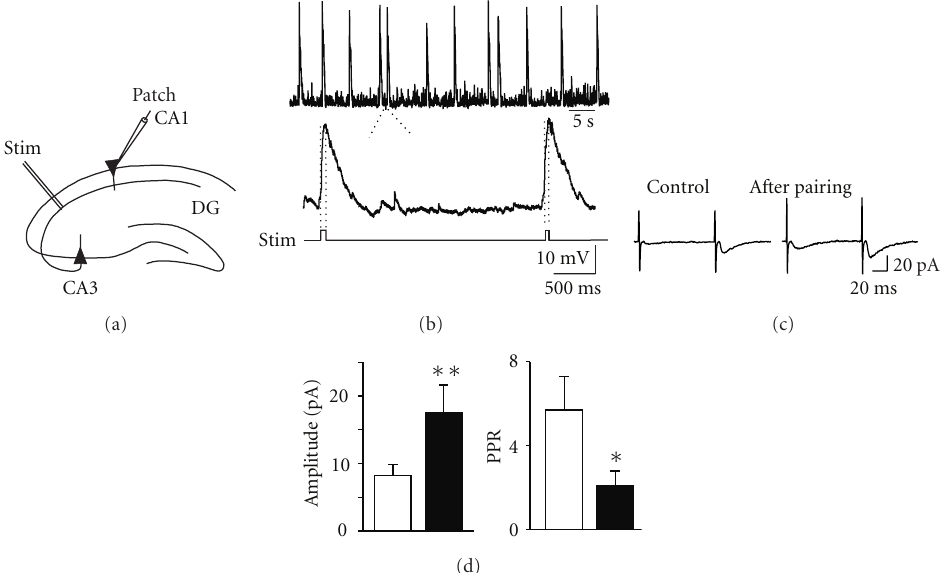
Figure 2: Pairing GABA-mediated GDPs with Scha ff er collateral stimulation persistently enhances synaptic strength at glutamatergic CA3- CA1 connections. (a) Experimental paradigm. (b) The rising phase of GDPs (between the dashed lines) was used to trigger synaptic stimulation (stim) (c) EPSCs evoked in CA1 principal cells by minimal stimulation of Scha ff er collateral, before and after pairing (average of 19 responses). (d) Each bar represents the mean peak amplitude of synaptic responses including failures ( n = 8) and the paired pulse ratio (PPR; n = 8), obtained before (open) and after (closed) pairing. (Modified from